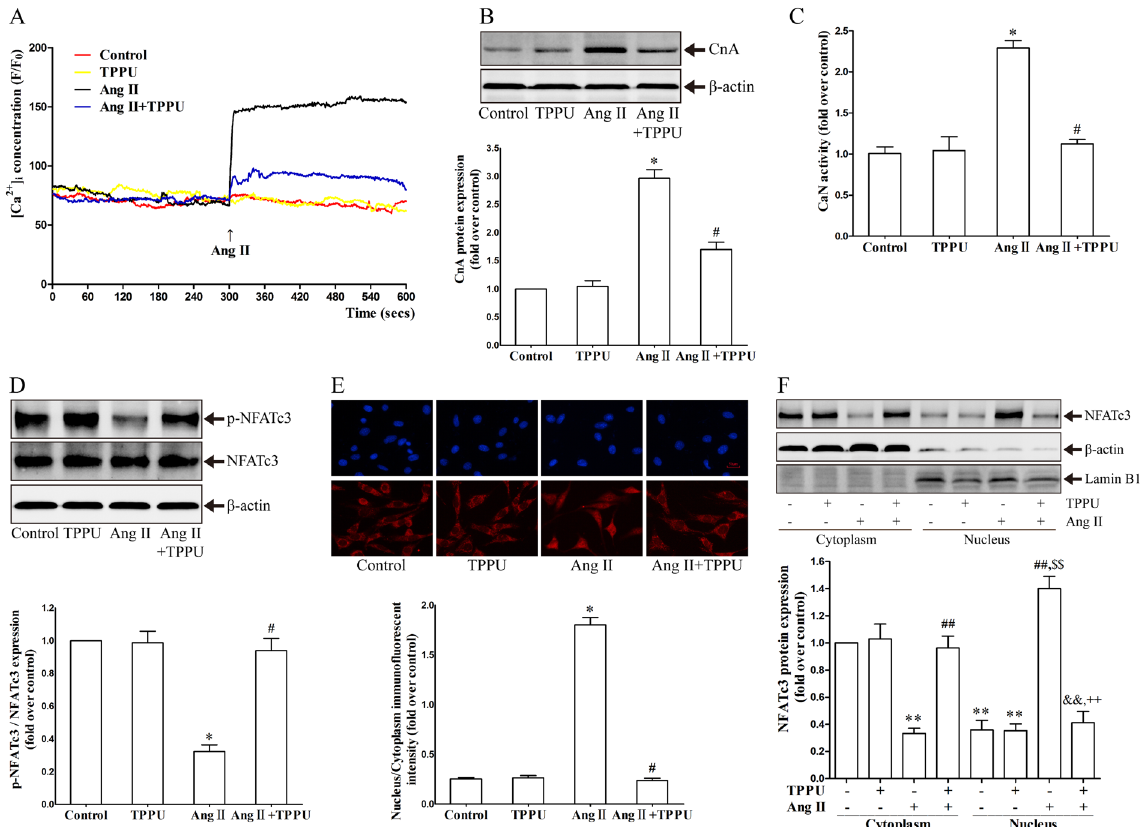
Figure 5. TPPU inhibited Ang II-activated Ca 2 + -calcineurin/NFATc3 signaling in AFs. ( A ) TPPU prevented Ang II-increased intracellular Ca 2 + concentration in AFs. ( B ) Representative immunoblots and quantitation of CnA protein expression in Ang II-stimulated AFs pretreated with or without TPPU. ( C ) Measurement of CaN phosphatase activity in Ang II-stimulated AFs pretreated with or without TPPU. ( D ) Representative immunoblots and quantitation of p-NFATc3/NFATc3 expression in Ang II-stimulated AFs pretreated with or without TPPU. ( E ) Immunofluorescent staining of NFATc3 in Ang II-stimulated AFs pretreated with or without TPPU (Red: Cy3, blue: DAPI). ( F ) Representative immunoblots and quantitation of NFATc3 nuclear translocation in Ang II-stimulated AFs pretreated with or without TPPU. Data were expressed as mean ± SEM, n = 4 for each group, * p < 0.05 vs. Control, # p < 0.05 vs. Ang II, ** p < 0.05 vs. Control (Cytoplasm), ## p <